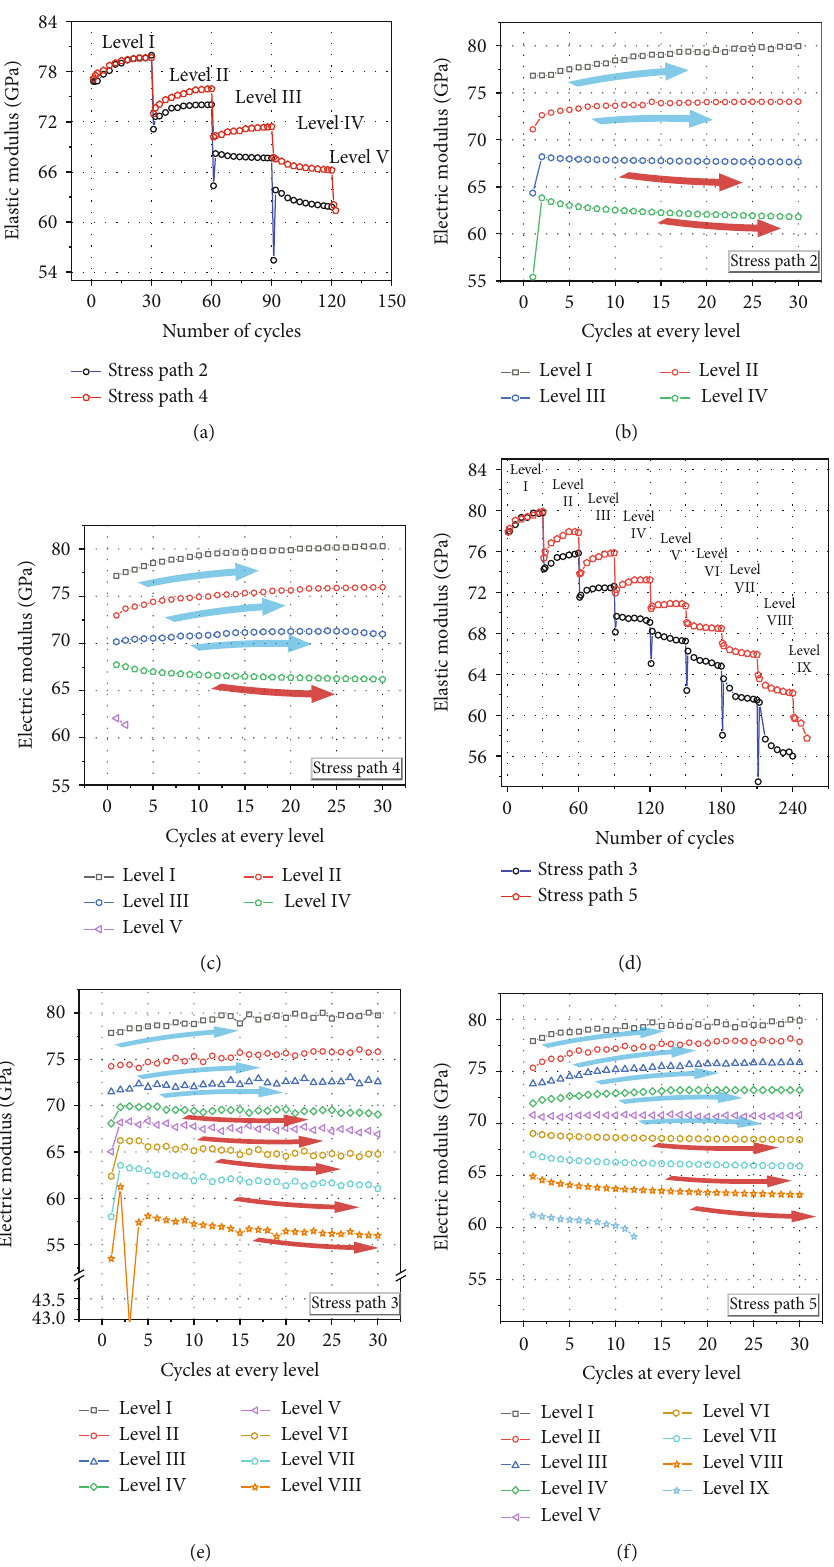
Figure 6: Elastic moduli of specimens evolution process under di ff erent stress paths. (a) E paths 2 and 4; (b) in fl uences of stress level on E d under stress path 2; (c) in fl uences of stress level on E d under stress path 4; (d) E d evolution with number of cycles under stress paths 3 and 5; (e) in fl uences of stress level on E d under stress path 3; (f) in fl uences of stress level on E d under stress path